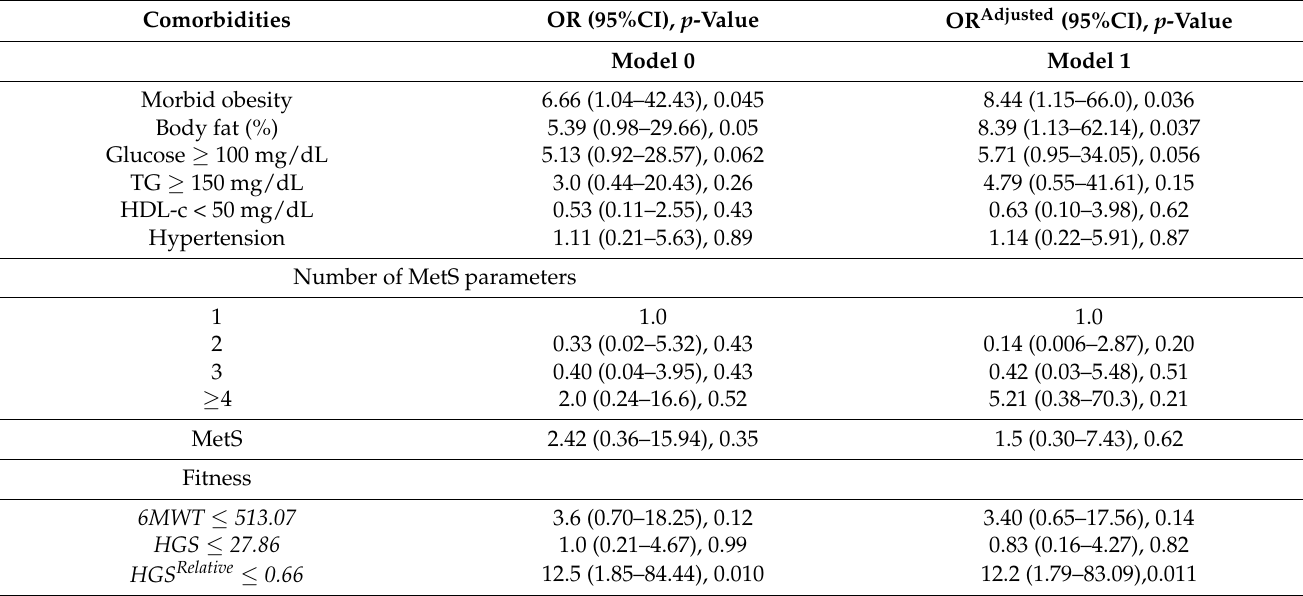
Table 4. Association between poor sleep quality with MetS markers and physical